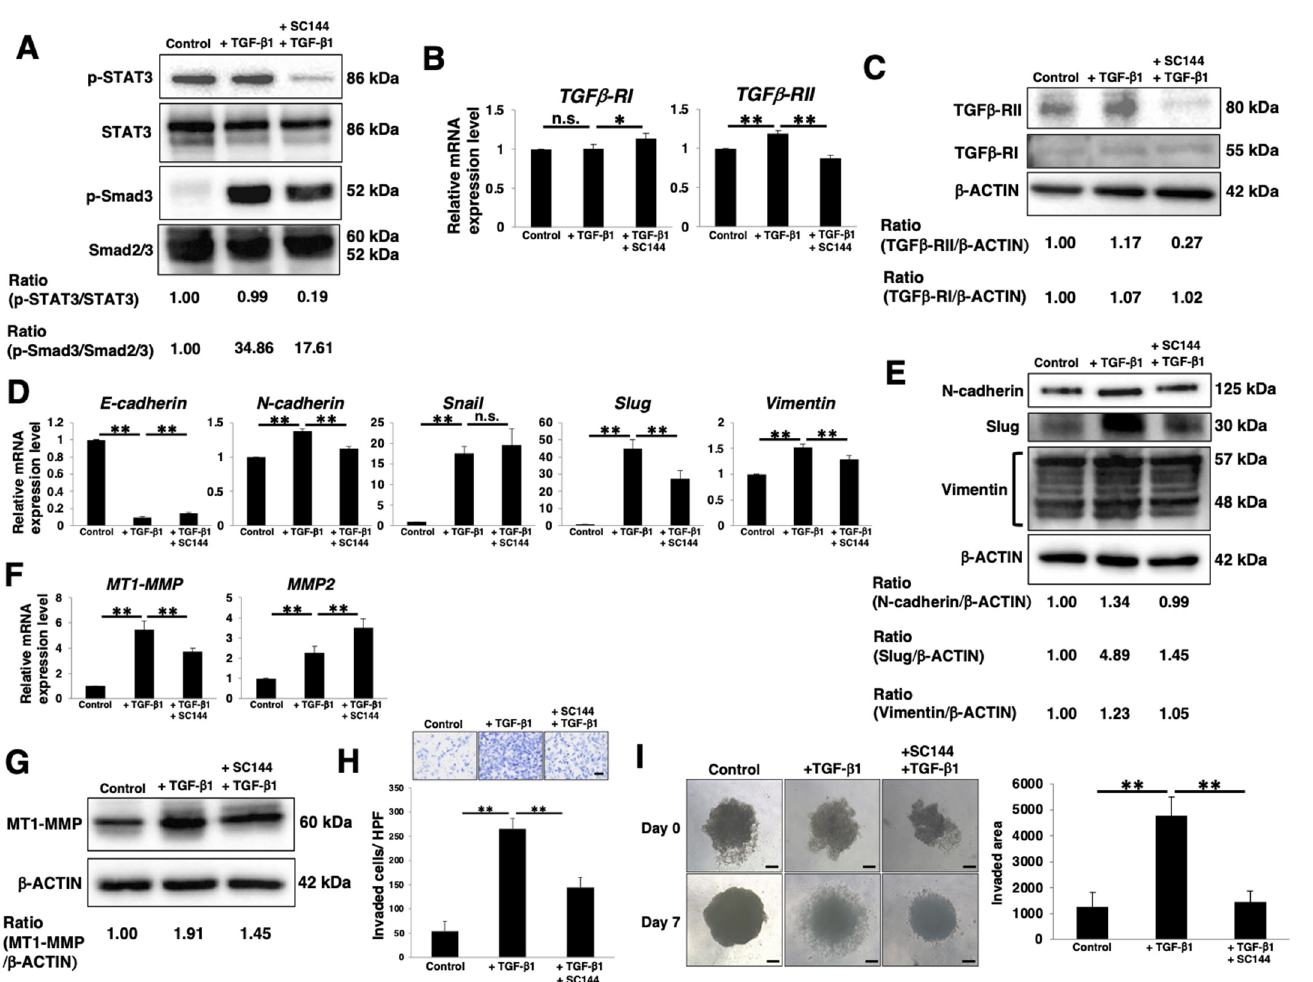
Figure 5. Correlation between gp130/STAT3 and the TGF/Smad pathway. PANC-1 cells were cultured for 4 days in 3D (sphere) conditions with or without 1 μ M SC144 and further incubated for 3 days with or without 10 ng/mL TGF- β 1. The cells were harvested and then used in following experiments. ( A ) Western blot analysis of p-gp130, gp130, p-STAT3, and STAT3. Relative band intensity is presented. ( B ) Real-time qPCR analysis of TGF β -RI and TGF β -RII . Results are normalized to values obtained for control cells (value = 1). Results are presented as means ± SD from three independent experiments. ( C ) Western blot analysis of TGF β -RI, TGF β -RII and β -ACTIN. Relative band intensity is presented. ( D ) Real-time qPCR analysis of EMT markers. Results are normalized to values obtained for control cells (value = 1). Results are presented as means ± SD from three independent experiments. ( E ) Western blot analysis of EMT markers and β -ACTIN (control). The relative band intensity is presented. ( F ) Real-time qPCR analysis of MT1-MMP and MMP2 . Results are normalized to values obtained for control cells (value = 1). Results are presented as means ± SD from three independent experiments. ( G ) Western blot analysis of MT1-MMP and β -ACTIN. Relative band intensity is presented. ( H ) Matrigel invasion assays in PANC-1 sphere cells. Representative results from measurements of 12 fields are presented. Scale bar: 100 μ m. ( I ) 3D invasion assay. Scale bar: 5 μ m. The histograms indicate the invaded area. Results are presented the as means ± SD from four sphere images. * p < 0.05; ** p < 0.01, n.s.: not significant.